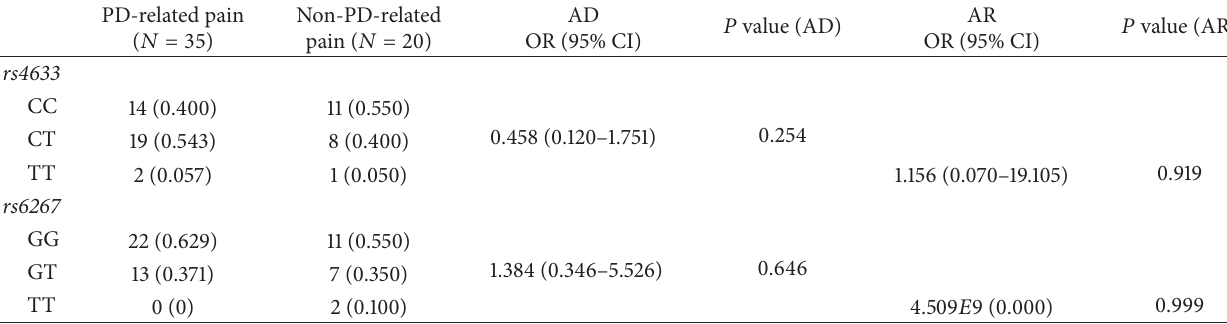
Table 3: COMT genotype and PD related pain.